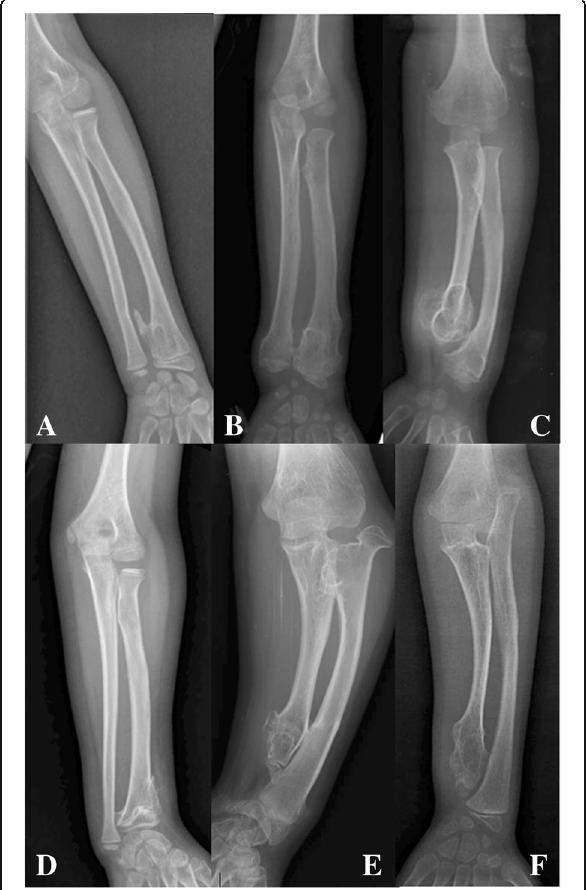
Fig. 1 a - b Grade 2, exostoses of the distal radius or ulna without obvious shortening of either bone or proportionate shortening; c Grade 3, Masada type I, exostoses of the distal ulna or radius resulting in a relatively shortened ulna and a bowing radius; d Grade 3, Masada type III, exostoses affected distal radius and resulted in a relatively shortened radius; e Grade 4, exostoses at the distal ulna and the proximal metaphysis of the radius, a relatively shortened ulna and dislocated radial head described as Masada type IIa; f Grade 4, Masada type IIb, the radial head is dislocated without